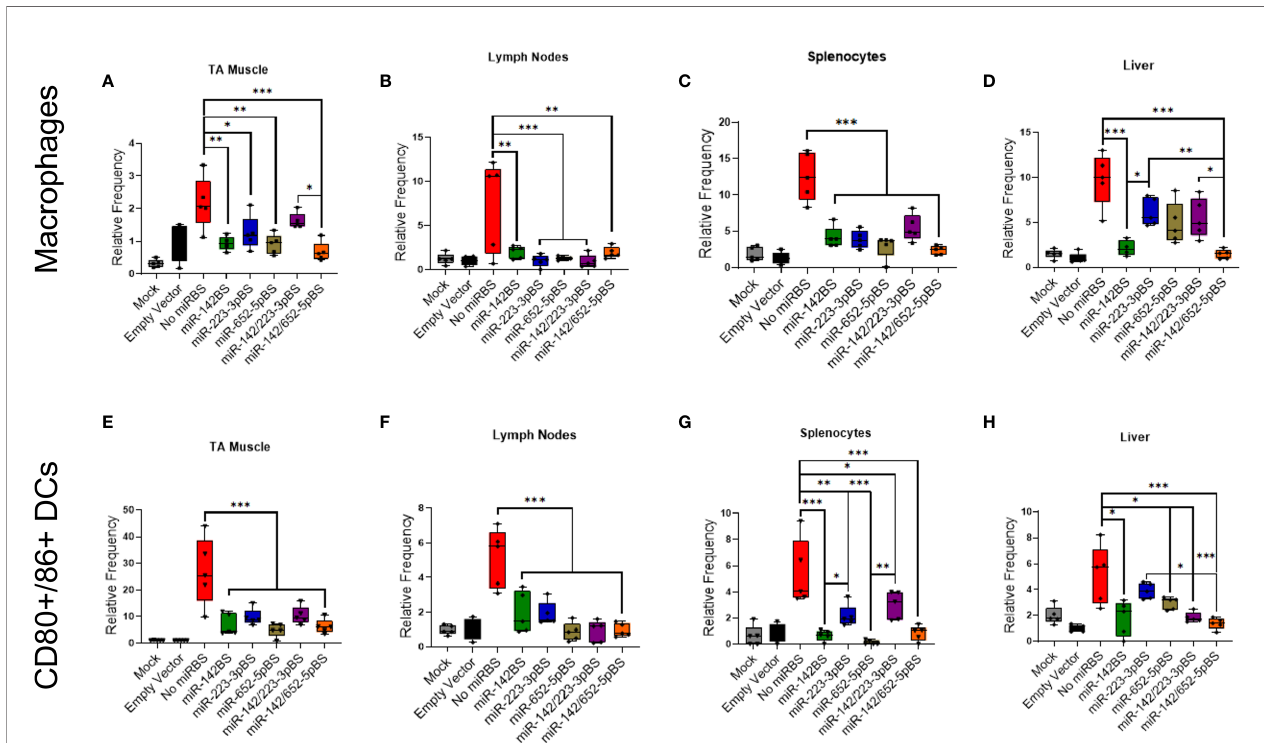
FIGURE 3 | Incorporation of miR-142BS, miR-223BS, and miR-652BS into rAAV1. OVA transgene vectors reduces macrophage and DC activation. rAAV1. OVA expressing vectors with or without miR-BSs (1 × 10 11 GCs/mouse) were delivered by i.m. injections into C57BL/6 mice. Four weeks after injection, cells were isolated from TAs, lymph nodes, spleens, and livers and stained for macrophage markers (CD11b+, F4/80+) and activated DCs (CD11c+, CD80+, CD86+) followed by fl ow cytometry analysis. Relative frequencies of macrophage populations (A – D) and activated DCs (E – H) are represented as box plots with means, fi rst and third quartile boundaries, and whiskers indicating max and min values. ( n = 5). Mock = AAV1.empty capsid. p values were determined by one-way ANOVA with Tukey ’ s post hoc test. * p < 0.05, ** p < 0.01, *** p <